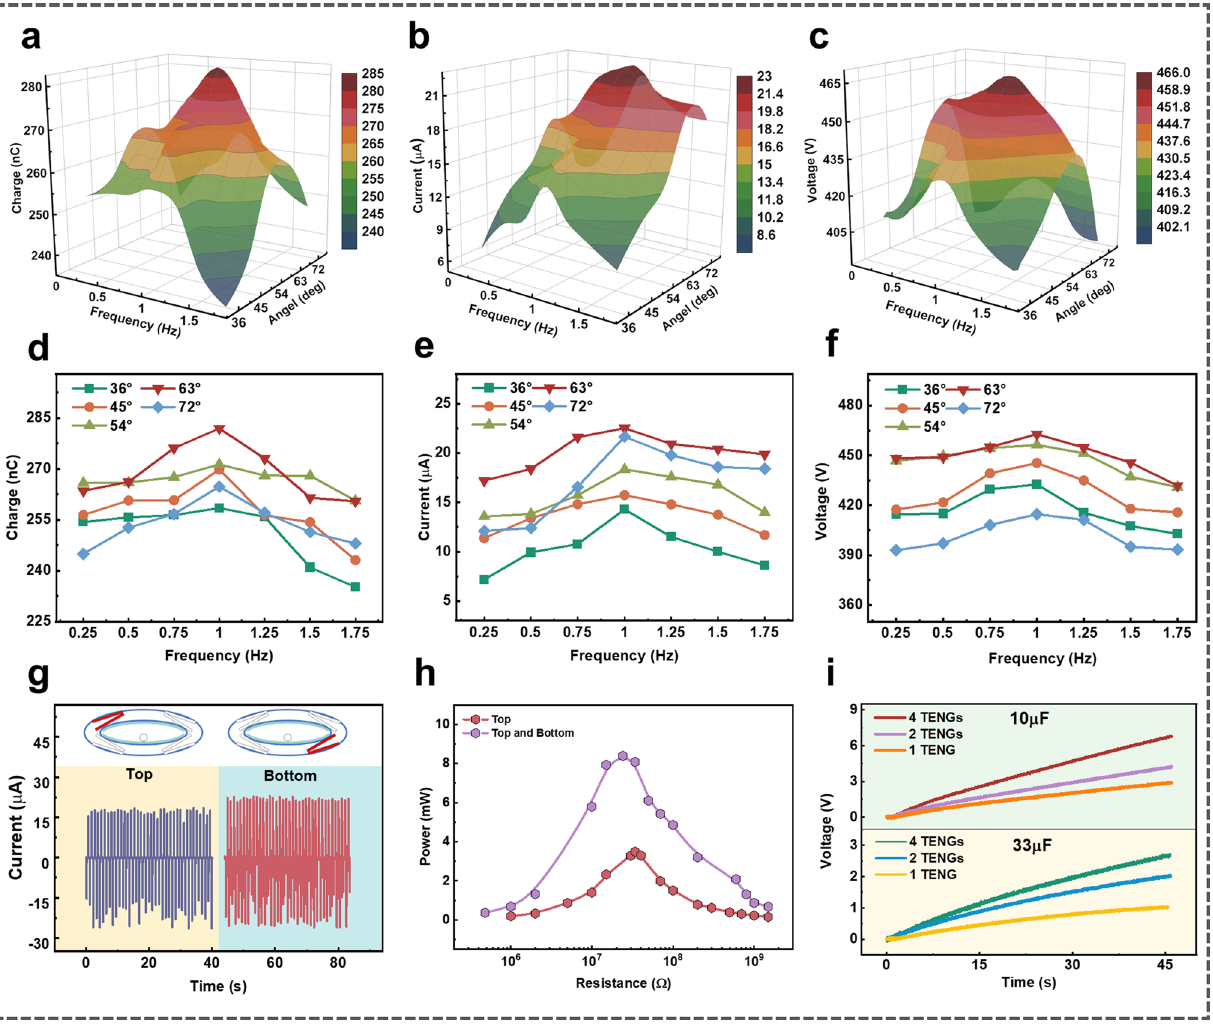
Fig. 4 The electrical output performance of the outer TENG. a–f 3D surface graphs of a Q SC , b I SC , and c V OC on changing both the working frequency and swing amplitude and their corresponding 2D graphs ( d–f ). g The short-circuit currents of a top and a bottom TENG at a fre- quency of 1 Hz and amplitude of 63°. h Peak power comparison of a single top TENG and a pair of diagonal TENGs connected in parallel (at 1 Hz and 63°). i Voltage curves of several commercial capacitors charged by different sets of outer TENGs (at 1 Hz and